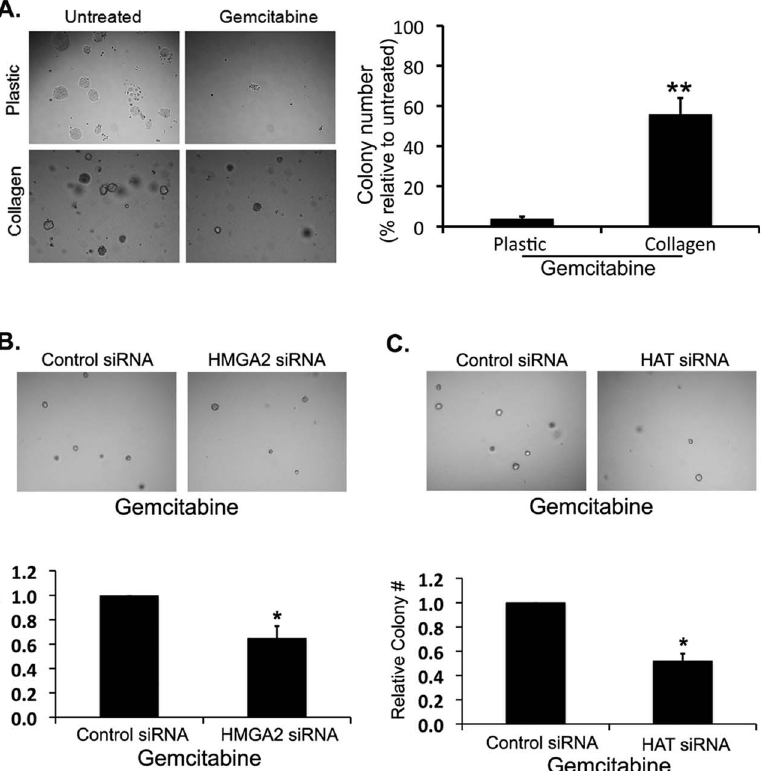
Figure 5. HMGA2 and HATs mediate protection against gemcitabine in three-dimensional collagen gels. A . CD18 cells grown on plastic or in three-dimensional collagen gels were left untreated or treated with gemcitabine for 24 hours. The cells were then trypsinized or extracted out of collagen by collagenase treatment. The cells were replated on tissue culture plastic or in three-dimensional collagen gels at low density ( left ). The cells were photographed 5 days later and counted ( right ). **, p , 0.001. The results are representative of at least three independent experiments. B, C . CD18 cells were transfected with control siRNA, HMGA2 siRNA ( B ) or combination of siRNAs against PCAF, GCN5 and p300 ( C ), allowed to recover overnight and then plated in collagen gels for 24 hours. The cells were then treated with gemcitabine for 24 hours, extracted out of collagen by collagenase treatment and then replated in three-dimensional collagen gels at low density. The cells were photographed 5 days later and counted. *, p , 0.05. The results are representative of at least 3 independent